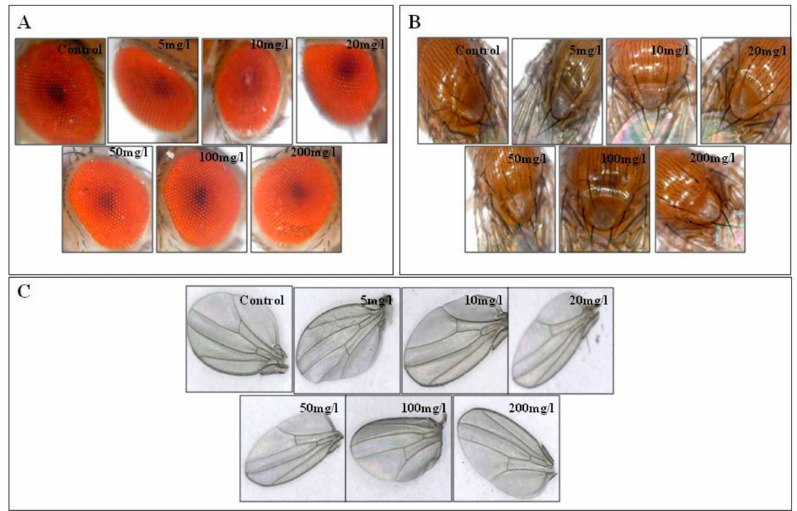
Figure 6. Adult phenotypes to check abnormalities in the ( A ) eye, ( B ) bristles and ( C ) wing. There were no such phenotypic defects observed after the